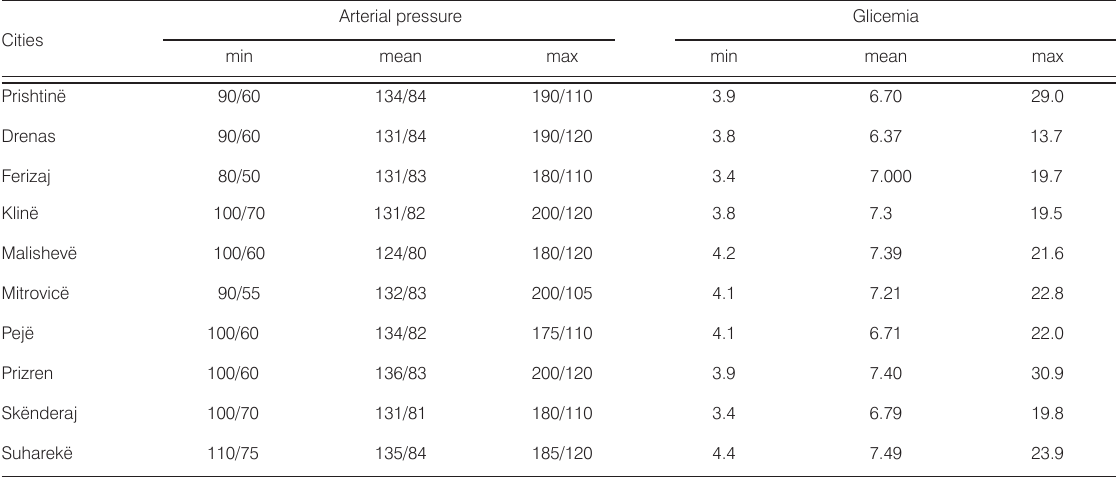
Table 2. Descriptive data for arterial pressure and glicemia as regards cities of Kosovo in